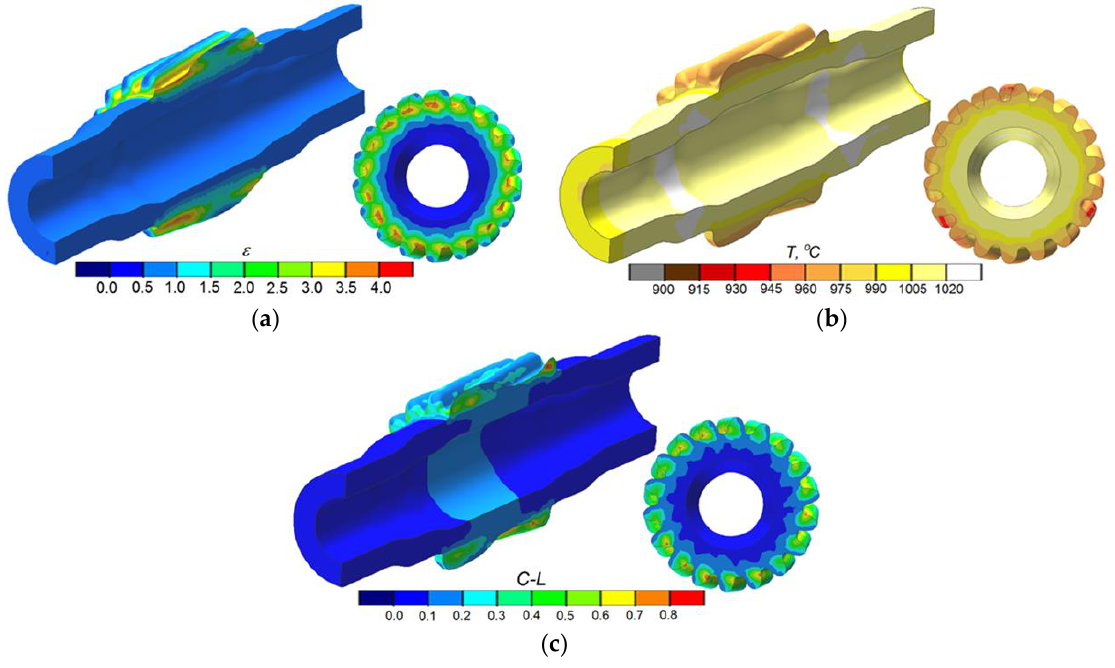
Figure 7. FEM results in the second operation of the rotary compression of a hollow stepped gear shaft: ( a ) effective strain, ( b ) temperature, ( c ) Cockcroft–Latham ductile fracture